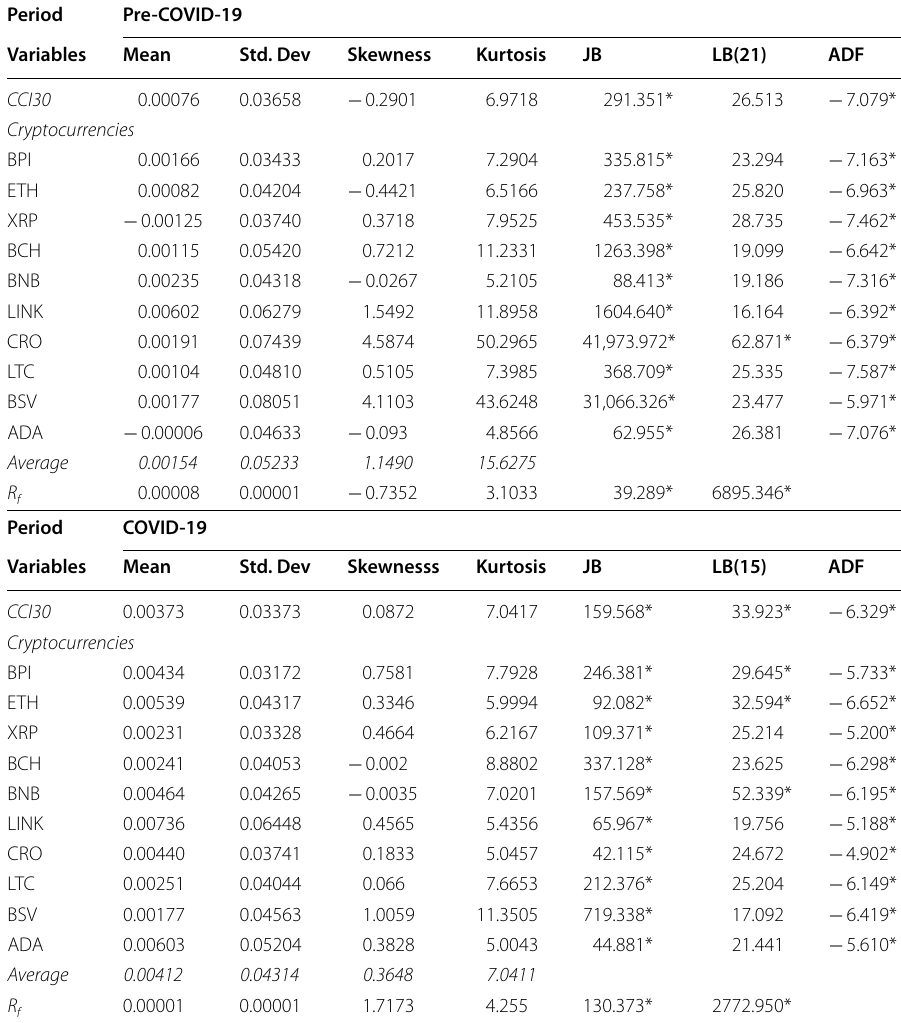
Table 2 Descriptive statistics of daily data during the pre-COVID-19 and COVID-19